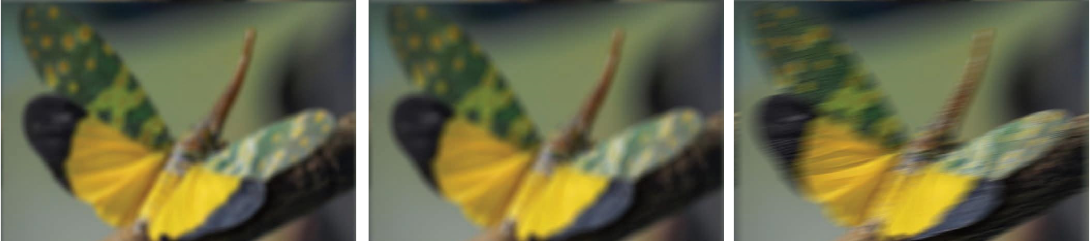
Figure 2: True images are blurred by matrices M